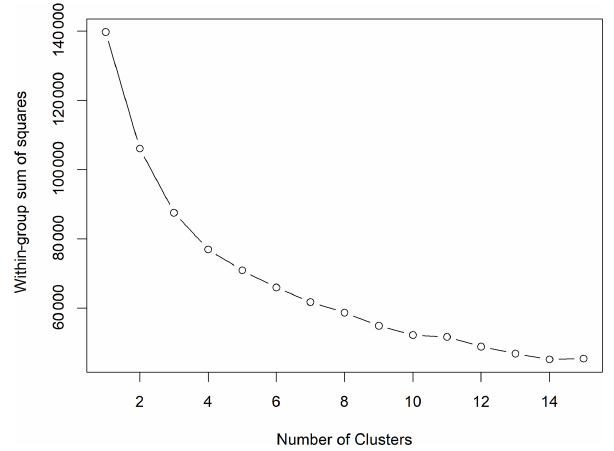
Figure 4. Diagnostic for the choice of the number of first-step clus- ters based on the within-group sum of squares.